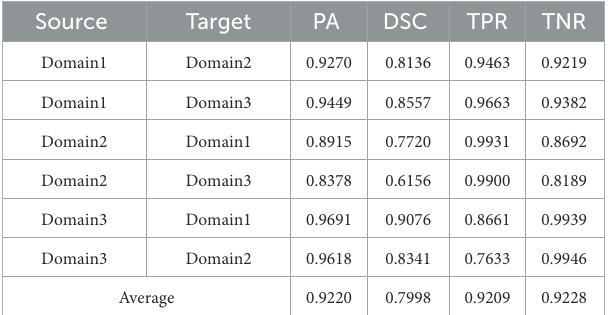
TABLE 4 Results on ultrasound thyroid nodule datasets with PAN (43) +AUG.